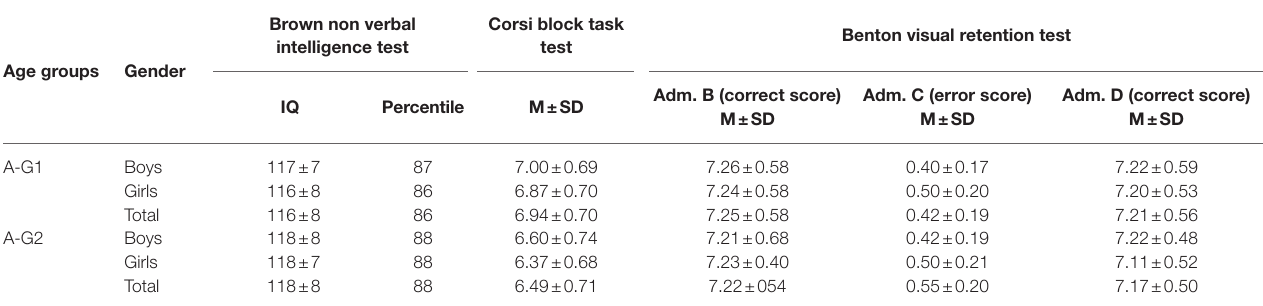
TABLE 2 | Results of the non-verbal neuropsychological tests.